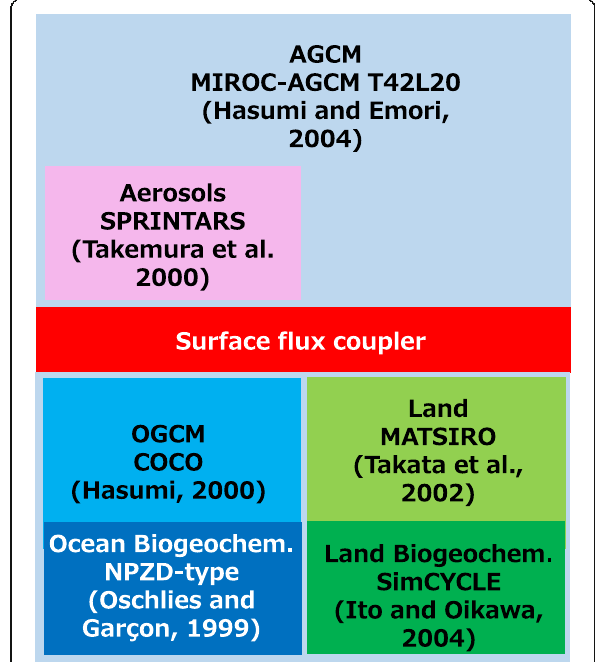
Fig. 1 Structure of the original version of the Earth system model (ESM) used for the Coupled Model Intercomparison Project (CMIP) Phase 3, developed by Team MIROC. From CMIP Phase 5 onwards, the full atmospheric chemistry component model CHASER was added. The land biogeochemical model was later replaced by SEIB- DGVM for CMIP Phase 5 and then by VISIT for CMIP Phase 6. All model acronyms are listed in the